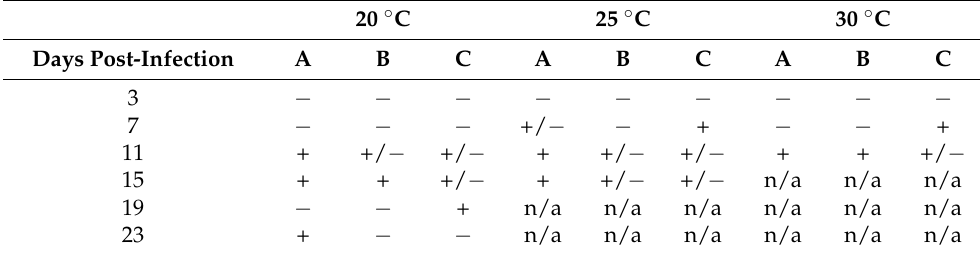
Table 3. BTV plaque isolations. Pools of midges (n = 10 per pool) were homogenized in triplicate (A, B, C) and used to inoculate BHK 21 cells for plaque isolation at days 3, 7, 11, 15, 19, and 23 post-blood meal. Dashes ( − ) indicate replicates where no plaques were identified. Pools that produced ≥ 5 plaques are denoted by (+), and those that produced plaques rarely (<5 plaques at lowest dilution) are indicated by (+/ − ). Days where no surviving insects were available to perform plaque assays are (n/a). 20 ◦ C 25 ◦